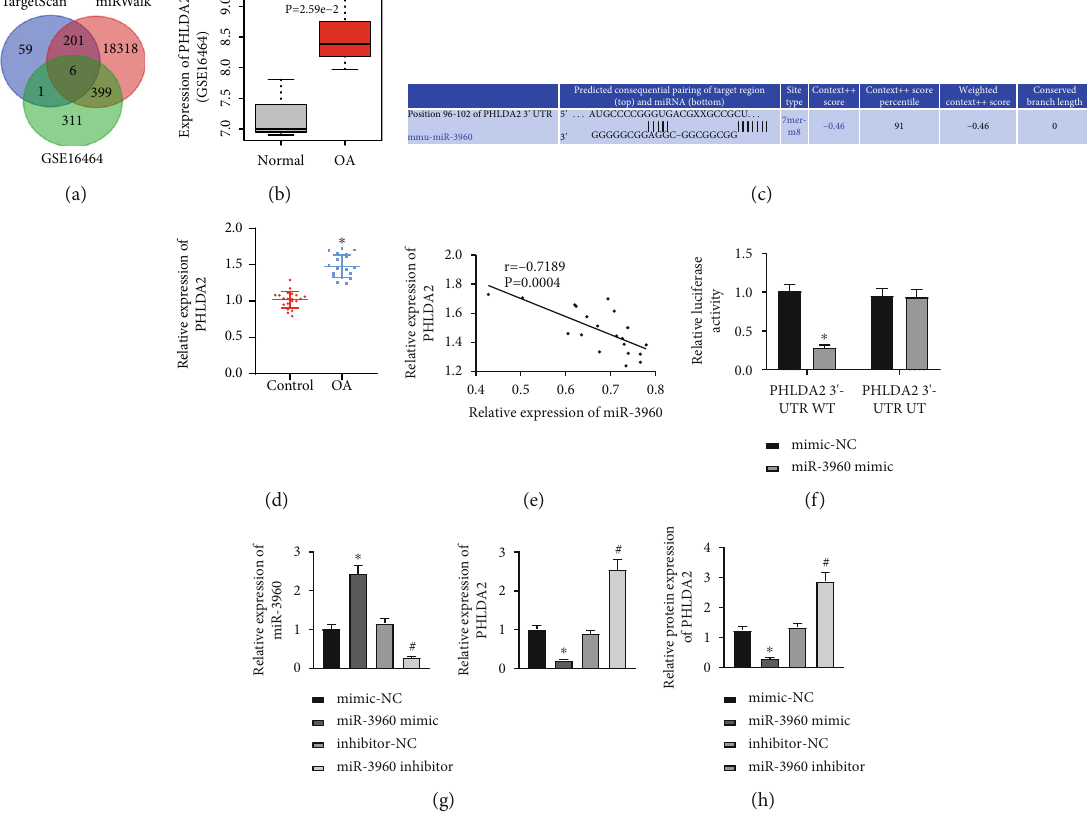
Figure 3: miR-3960 targets and negatively regulates PHLDA2. (a) The target gene of miR-3960 predicted using TargetScan, miRWalk, and upregulated genes in the OA-related GSE16464 dataset from GEO database. (b) PHLDA2 expression in GSE16464 dataset. (c) The binding sites between miR-3960 and PHLDA2 predicted using starBase. (d) PHLDA2 mRNA level in the cartilage tissues of OA patients ( n = 20 ) and patients with traumatic amputation ( n = 20 ) determined by RT-qPCR. (e) Correlation between miR-3960 and PHLDA2 analyzed by Pearson ’ s correlation coe ffi cient. (f) The binding of miR-3960 to PHLDA2 veri fi ed using the dual-luciferase reporter gene assay. Chondrocytes were transduced with miR-3960 mimic or miR-3960 inhibitor. (g) miR-3960 expression and PHLDA2 mRNA level in the chondrocytes determined by RT-qPCR. (h) PHLDA2 protein level in the chondrocytes determined by immunoblotting. ∗ p < 0 : 05 vs. patients with traumatic amputation or chondrocytes treated with mimic-NC; # p < 0 : 05 vs. chondrocytes treated with IL-1 β ; & p < 0 : 05 vs. chondrocytes treated with inhibitor-NC. Data are shown as the mean ± standard deviation of three technical replicates. Data between two groups were compared by independent t -test. Data comparisons among multiple groups were analyzed by the one-way ANOVA with Tukey ’ s post hoc